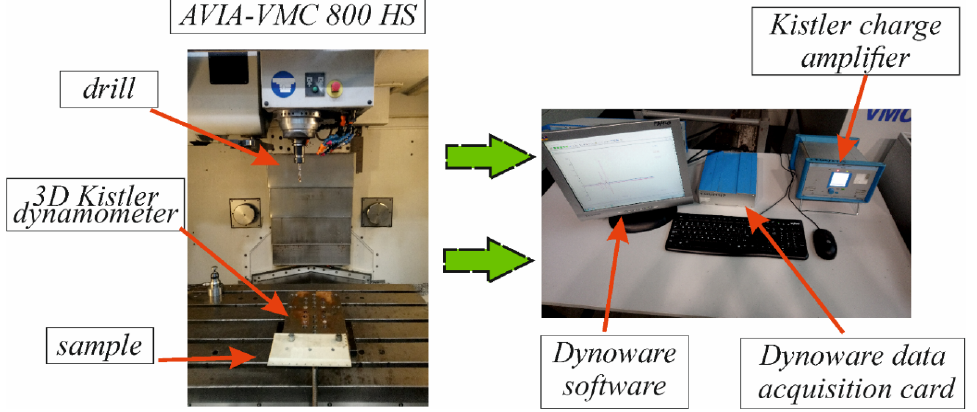
Figure 3. Setup of the machining process.